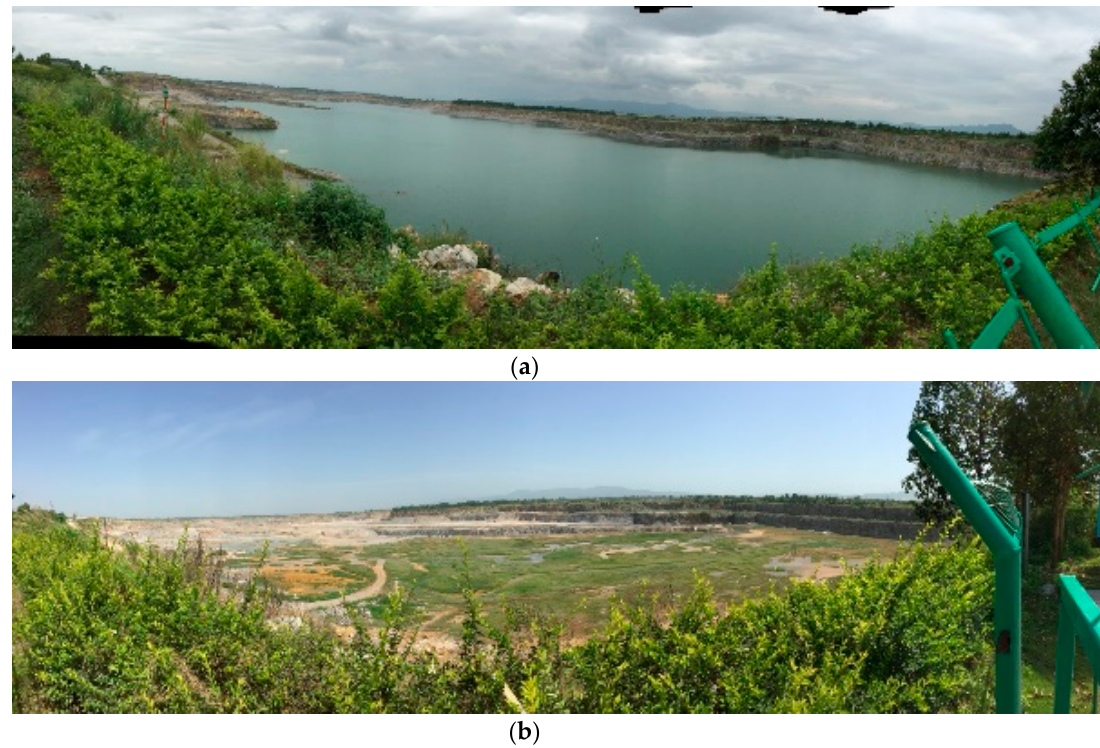
Figure 13. Water observation curve.